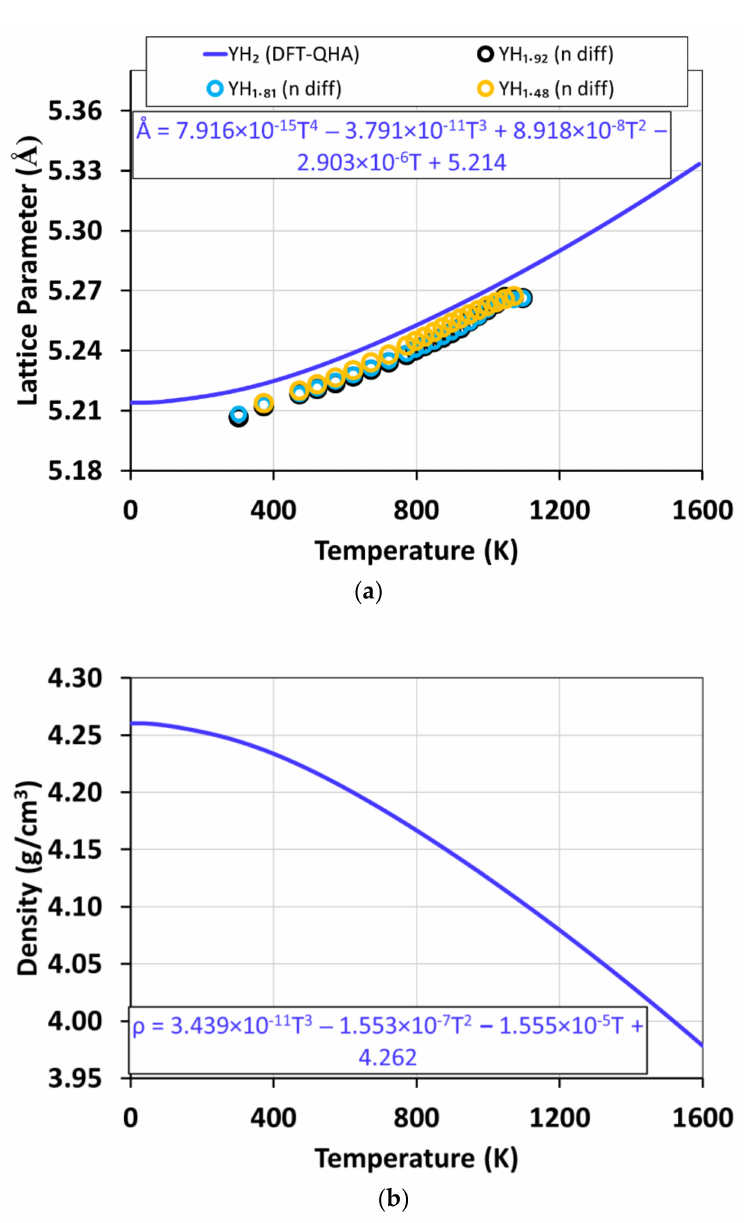
Figure 6. Calculated using [21]. Temperature-dependent ( a ) lattice parameters, and ( b ) gravimetric density. For all three sub-figures, DFT-QHA-predicted δ - YH 2 parameters are shown using solid blue lines, whereas neutron diffraction measurements are shown using circular markers